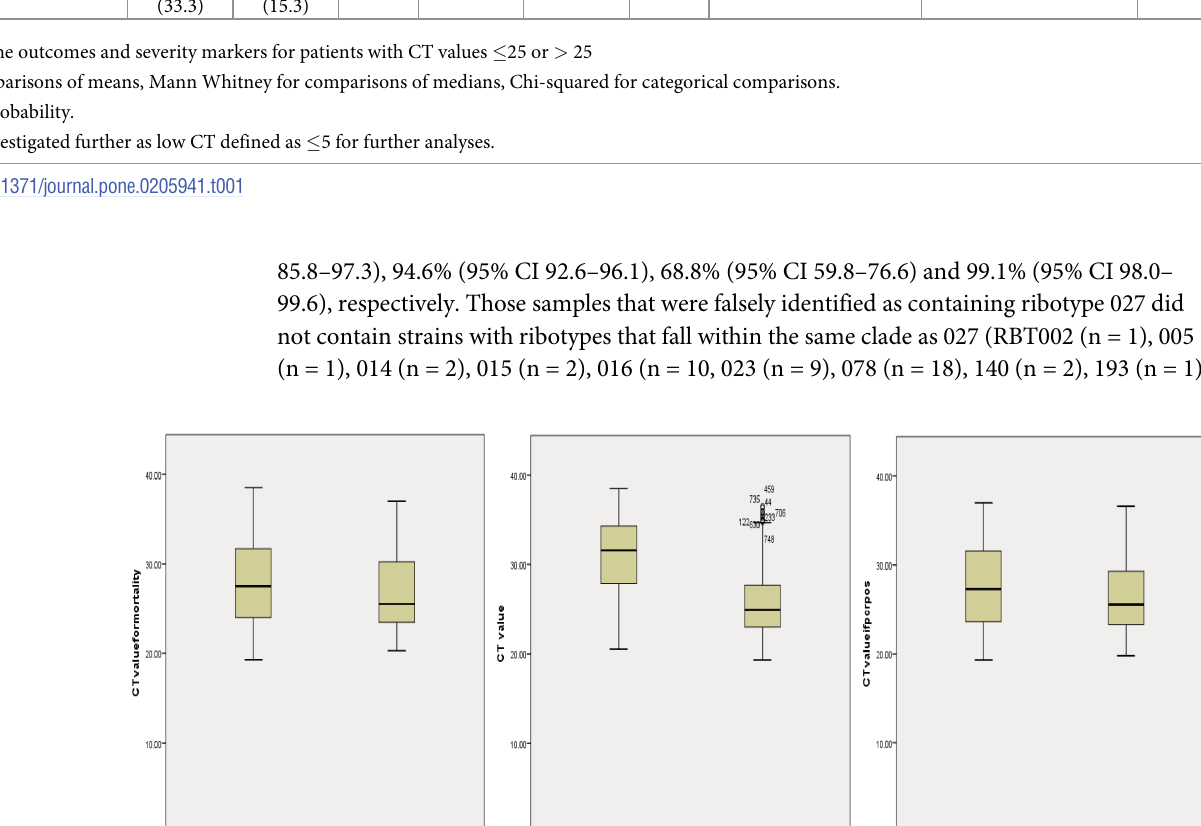
Table showing the outcomes and severity markers for patients with CT values � 25 or > 25 � T-test for comparisons of means, Mann Whitney for comparisons of medians, Chi-squared for categorical comparisons. b fishers exact probability. c CT � 24 not investigated further as low CT defined as � 5 for further analyses.